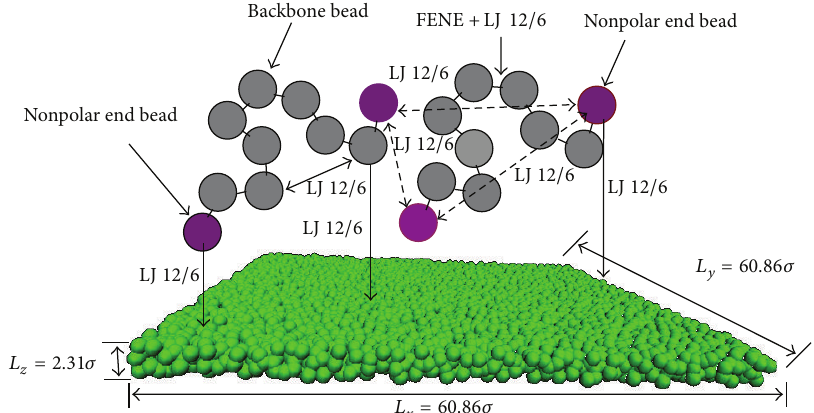
Figure 1: Coarse-grained bead spring model of nonfunctional lubricant PFPE Z on a DLC thin film [11].